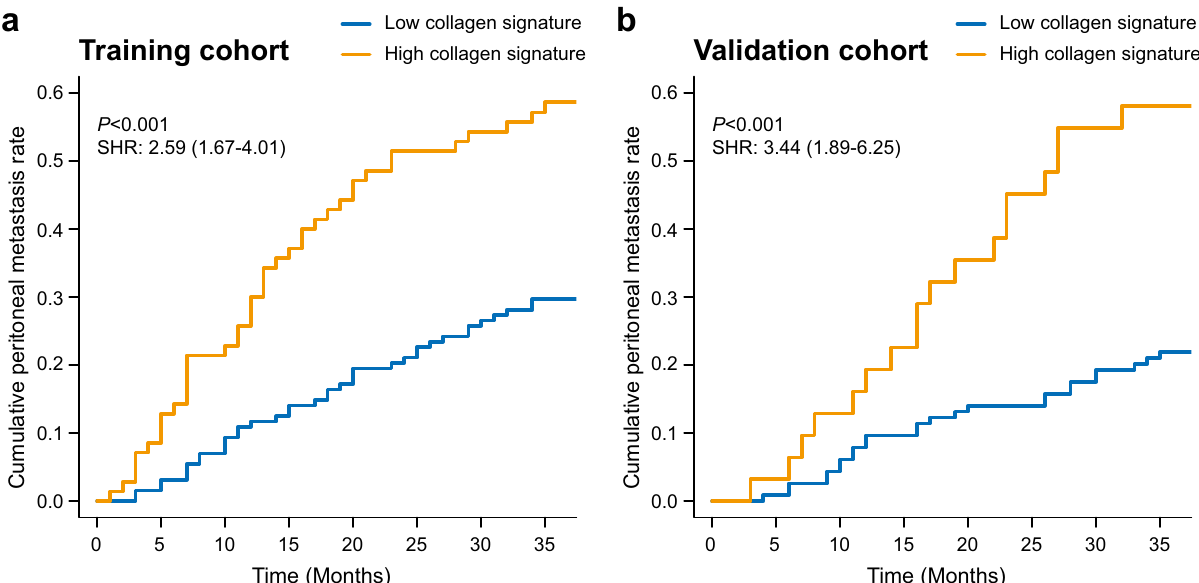
Fig. 2 Collagen signature and peritoneal metastasis in the training and validation cohorts. Cumulative peritoneal metastasis rate strati fi ed by the collagen signature in the ( a ) training and ( b ) validation cohorts. The comparisons of the cumulative peritoneal metastasis between two subgroups are performed using a two-sided Gray ’ s test. SHR, subdistribution hazard